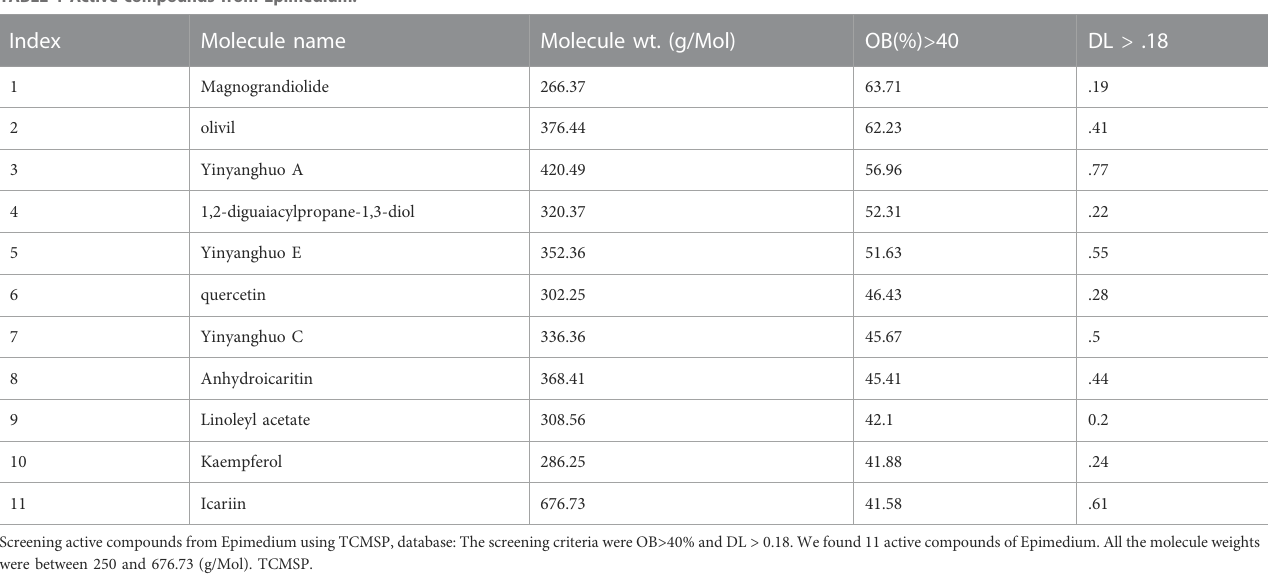
suppressed CYP3A4 activity (Figure 7A, p < 0.01). The inhibition rate was 58.0%, 74.1%, 89.9%, and 97.4% at an incremental (Figure 7A). Based on the kaempferol inhibition of CYP3A4, we calculated a IC50 and IC90 of 9.8 μ g/mL and 29.54 μ g/mL, respectively (Figures 7B, C).